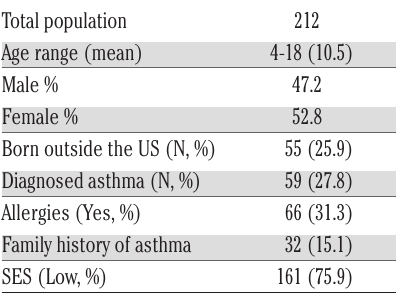
Table 2. Demographics and clinical charac- teristics.